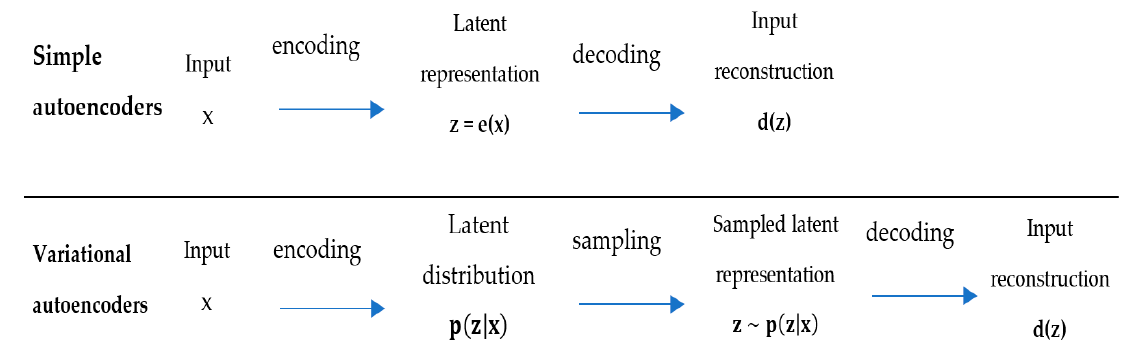
Figure 7. Difference between autoencoders and variational autoencoders [50]. Using this model will enable parameters describing the distribution of each dimension in latent space to be deduced as shown in Figure 8. Two vectors describing the mean and variance of the latent state distributions are outputted. By assuming the covariance matrix only has nonzero values on the diagonal, the information can be represented with a simple vector. To construct a reconstruction of the original output, the decoder model then generates a latent vector by sampling from these defined distributions [52].